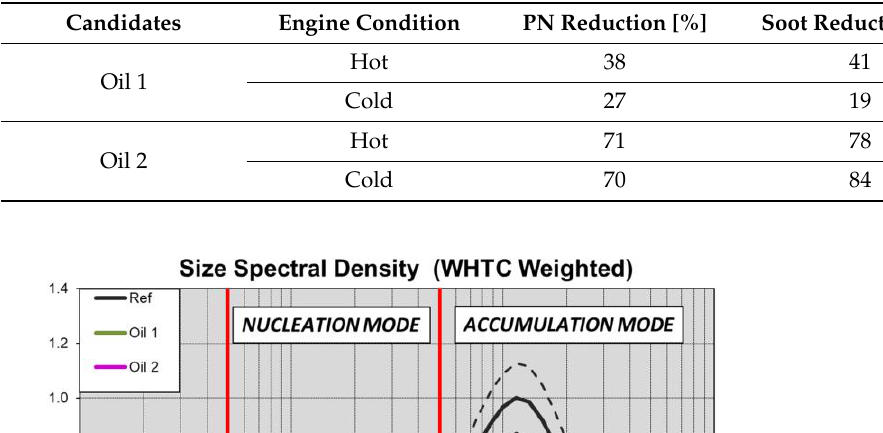
Figure 3. Combined mean dimensionless PN and Soot results. Table 7. Candidates’ PN/Soot percentage reduction vs. the Reference oil.